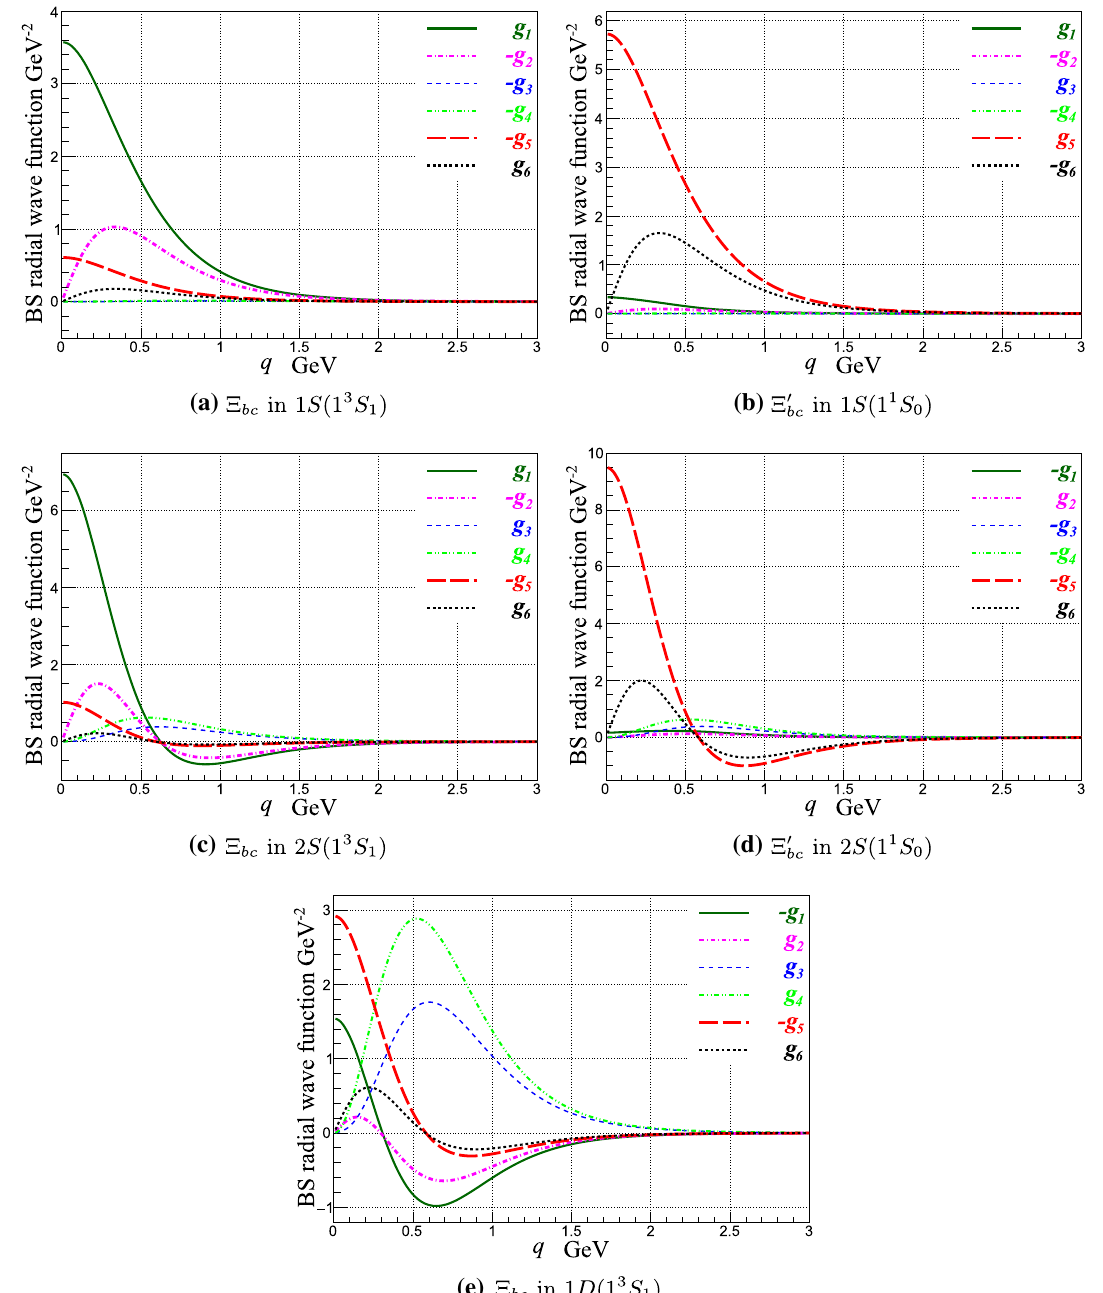
+ ( bcu ) baryons for the first five energy levels with the S -wave ( bc ) -diquark cores 2 + ( bcq ) baryons (in GeV). The unprimed (cid:2) bc and (cid:3) bc denote the baryons with 1 + 2